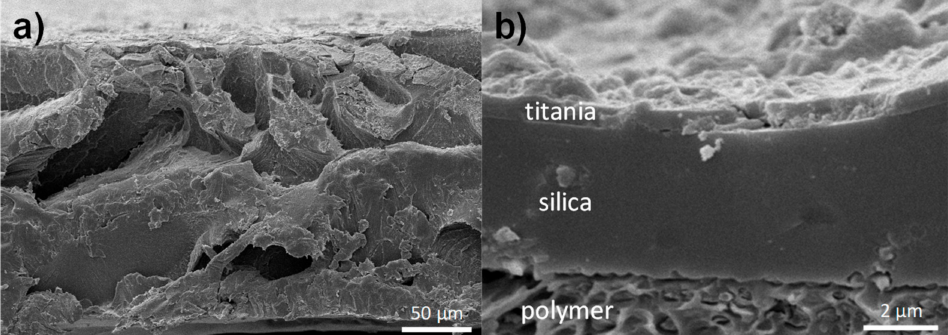
Figure 3. Cross-sectional SEM images of the deposited polymeric foil ( a ) and of the final device ( b ). XRD patterns of the complete device collected on a Philips PW 3710 Bragg-Brentano goniometer proved unsuccessful in determining the structural composition of the TiO 2 top layer, due to